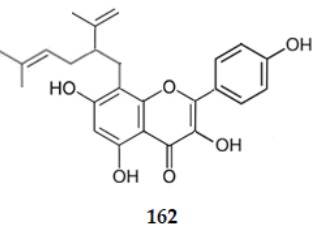
Figure 18. Structure of lavandulylflavonol 162 that inhibits AChE.